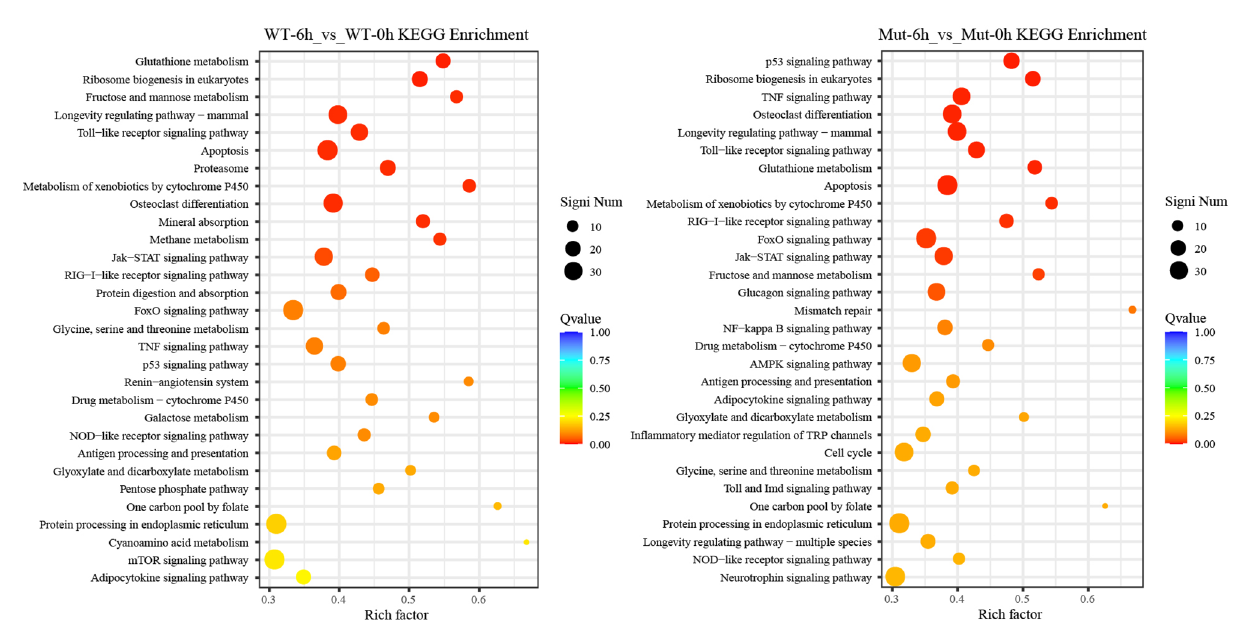
FIGURE 2 | The top 30 enriched KEGG pathways in WT-6h_vs_WT-0h and Mut-6h_vs_Mut-0h. The color and size of the dots indicate Q-values and DEG numbers in pathways,